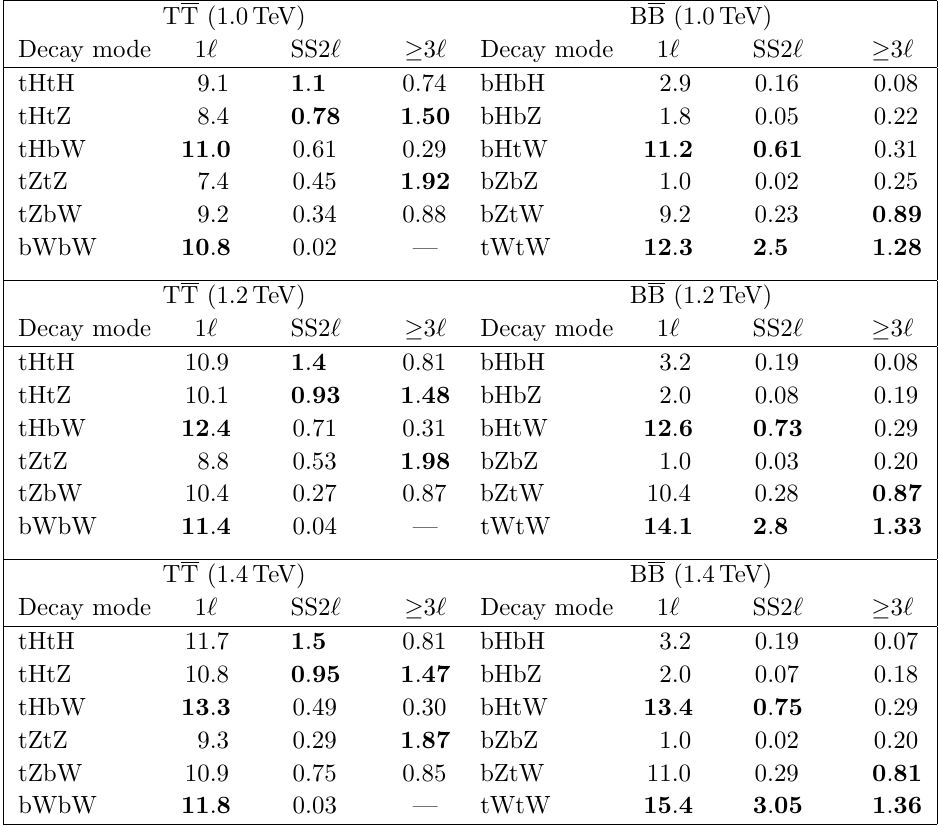
Table 4 . Signal e(cid:14)ciencies in the single-lepton, same-sign dilepton, and trilepton channels, split into the six possible (cid:12)nal states of both TT and BB production, for three mass points. E(cid:14)ciencies, stated in percent, are calculated with respect to the expected number of events in the corresponding decay mode, before any selection. The most sensitive decay modes for each channel are noted in bold. The e(cid:14)ciency for bWbW events in the same-sign dilepton and trilepton channels is negligible, as is the e(cid:14)ciency for bZbZ events in the same-sign dilepton channel. observed event yields for the single-lepton, SS dilepton, and trilepton channels are listed in tables 5{7. The T quark distributions and event yields are for the singlet branching fraction benchmark. No signi(cid:12)cant excess of data above the background prediction is observed.